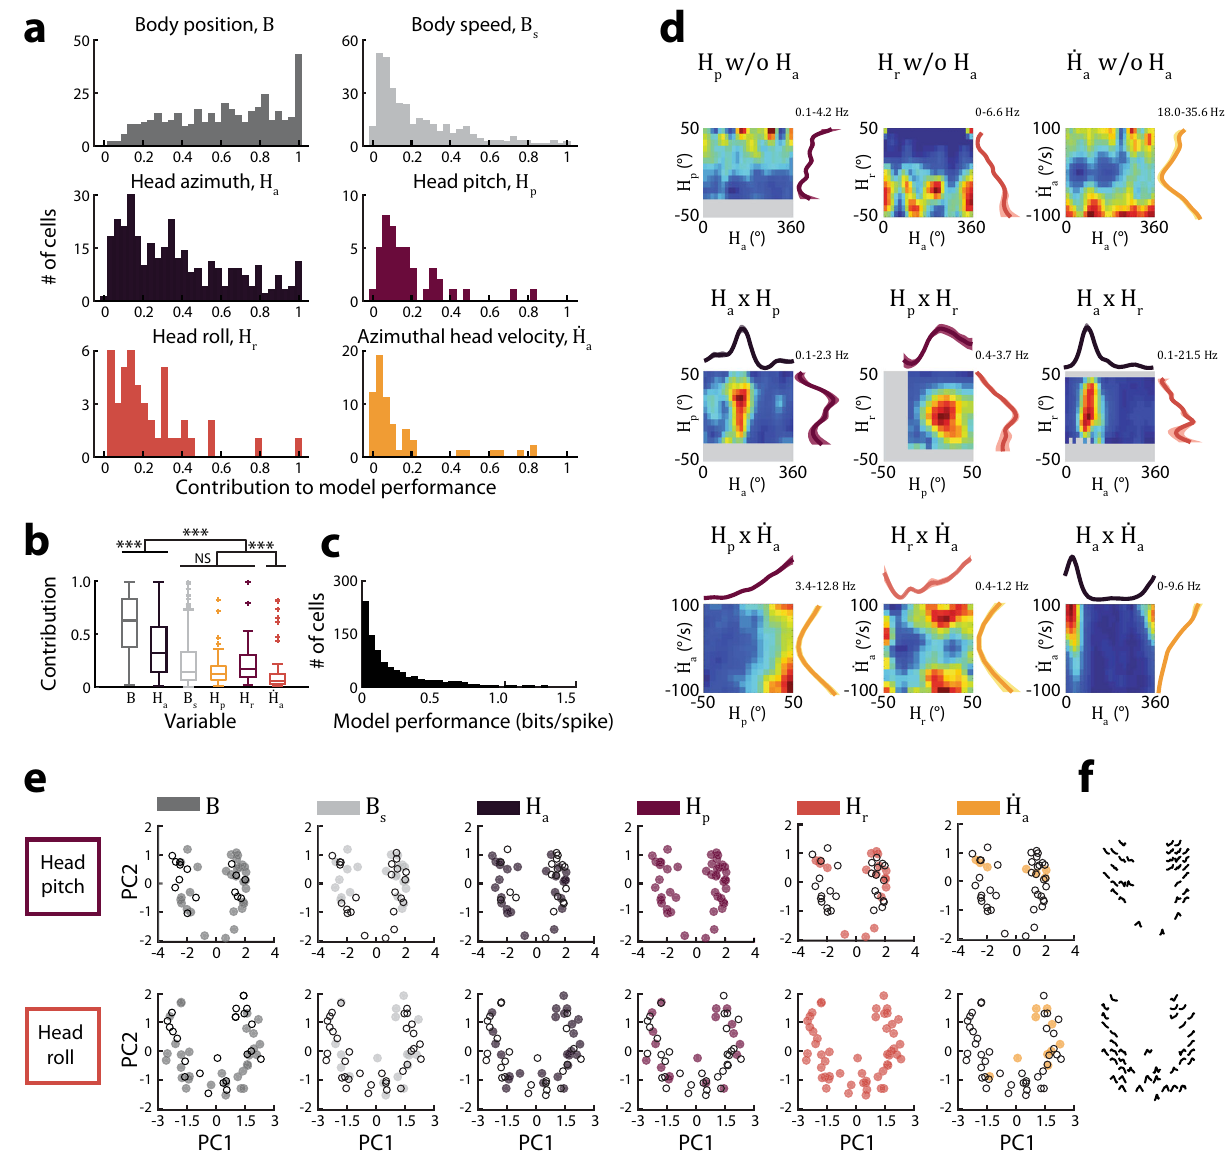
Fig. 3 Conjunctive tuning to head position and conventional navigational variables. a The contribution of each variable to model performance (log- likelihood increase (LLI) in information compared to a mean fi ring rate model; median [1st – 3rd quartile], n = # of cells signi fi cantly encoding the variable of interest and at least one other variable; B = 0.64 [0.38 – 0.84], n = 394; H a = 0.32 [0.14 – 0.58], n = 327; B s = 0.15 [0.06 – 0.34], n = 332; H p = 0.13 [0.07 – 0.18], n = 44; H r = 0.17 [0.10 – 0.31], n = 44; _ H a = 0.06 [0.02 – 0.13, n = 64]). b Comparison of variable contributions. Boxplots; box, interquartile range; solid line, median; whiskers, range; outliers plotted separately ( number of cells as in ( a ); Χ 2 = 410.3, P = 1.8e − 86, df = 5; Kruskal – Wallis test followed by post hoc two-sided Wilcoxon rank-sum comparisons with α = 0.0033 after Bonferroni correction for multiple comparisons). ***for all signi fi cant pairwise comparisons, P < 0.00055. c The spike-normalized average log-likelihood increase in information across 10 folds of held-out data for all cells signi fi cantly encoding at least one variable (median [1st – 3rd quartile]; 0.11 [0.04 – 0.26], n = 869). d Joint tuning curves. Examples where the cell encoded variable a but not b are labeled “ a w/o b ” (w/o; without). Examples where the cell encoded both variables are labeled “ a × b ” . Minimum and maximum fi ring rates are shown at top, with warmer colors indicating higher fi ring rates. Unvisited bins are shown in gray. Only model-derived tuning curves for signi fi cantly encoded variables are shown. e For each head position variable we constructed a two-dimensional “ tuning curve pro fi le space ” (Methods, Supplementary Fig. 11). Within a plot, each circle represents a cell whose tuning curve was projected onto the fi rst two principal components. Subplots are colored according to whether the cell signi fi cantly encoded each additional variable. f Example tuning curves from a subset of cells are shown at the cell ’ s position in the tuning curve pro fi le space. B , body position; B s , body speed; H a , azimuthal head direction; H p , pitch; H r , roll; _ H a , azimuthal head